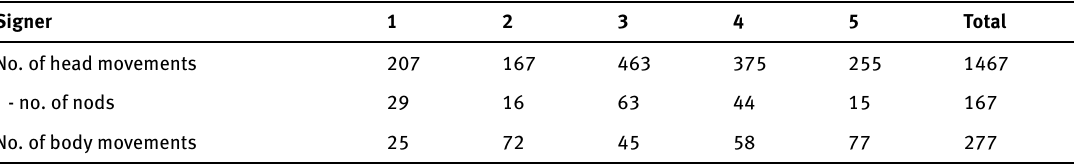
Table 8. Movements of the head and body in the main